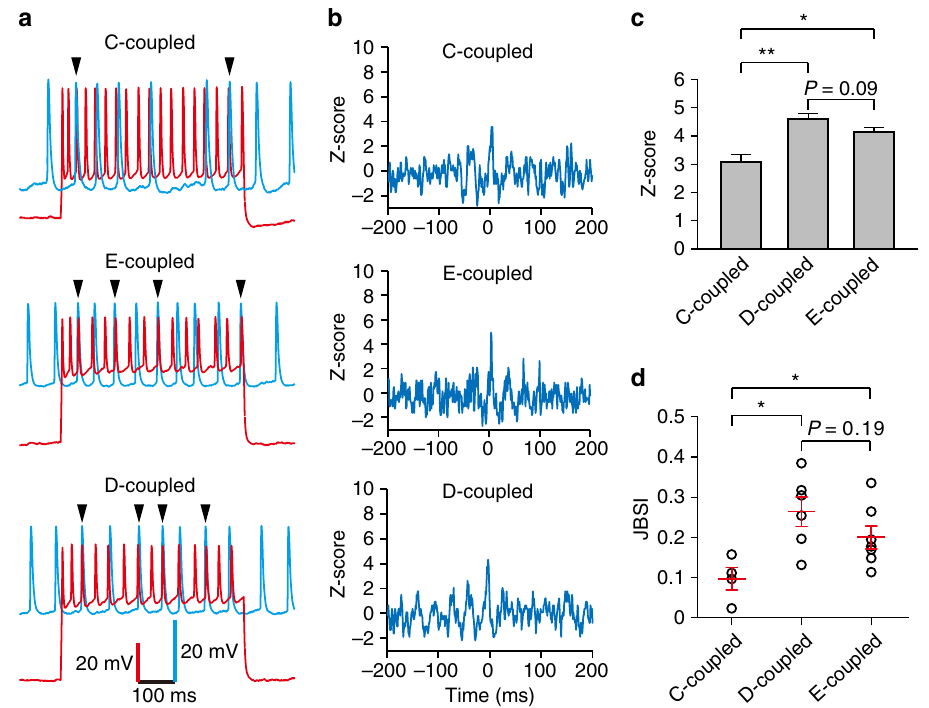
Figure 4 | The effect of bidirectional chemical synapse in controlling firing synchrony between layer 1 interneurons. To test for firing synchrony in three interneuron groups (C-coupled, E-coupled and D-coupled), paired spike trains were elicited by suprathreshold current in the driver cell (red traces, 30–50Hz) and by tonic suprathreshold depolarization in the follower cell (blue traces, B 10Hz), respectively. ( a ) Sample traces of paired spike trains from two neurons coupled by different patterns of connectivity in neocortical layer 1, the arrowheads indicate the synchronous spikes. ( b ) Normalized cross- correlogram ( Z -score) for neuron pairs in ( a ). Bin size is 2ms. Note that the cross-correlogram exhibited a peak B 0ms in all three groups. ( c ) Average Z -scores for different patterns of connectivity. Note that Z -scores of E- and D-coupled pairs were significantly higher than that of C-coupled pairs, and Z -scores of D-coupled pairs were slightly lower than that of E-coupled pairs. ( d ) Average JBSI values for different patterns of connectivity. C-coupled pairs ¼ 4, E-coupled pairs ¼ 6, D-coupled pairs ¼ 7, from 10 mice. * P o 0.05, ** P o 0.01, two-tailed paired t -test. Error bars represent mean ±